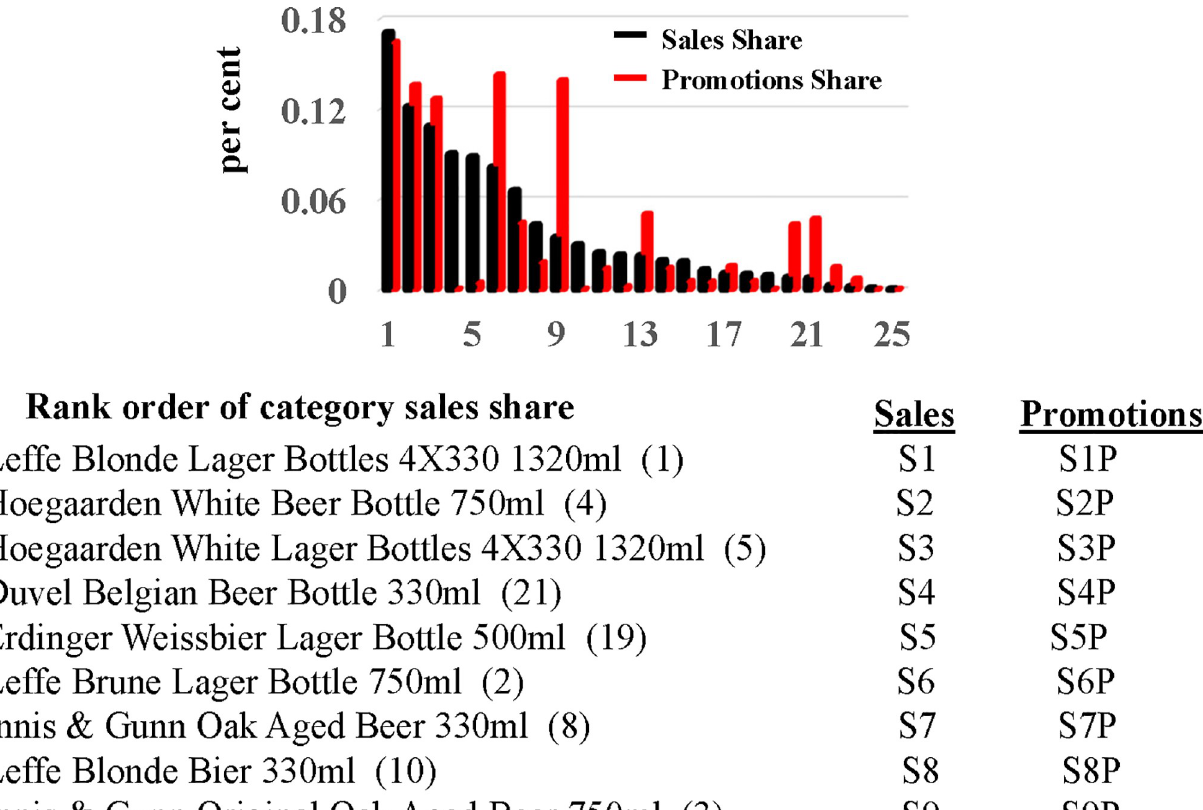
Fig 2. Description of Tesco dataset. The bar chart plots the category sales and promotions shares for each brand calculated over the entire 104 weeks of the dataset in declining order of sales shares. We focus on the brands with the largest nine category sales shares since they exhibited the most continuous sales/promotions records. The Leffe and Hoegaarden brands are both owned by ABInbev.